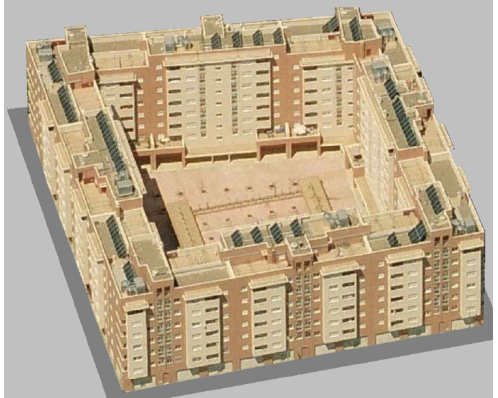
Figure 1. Aerial view of the studied